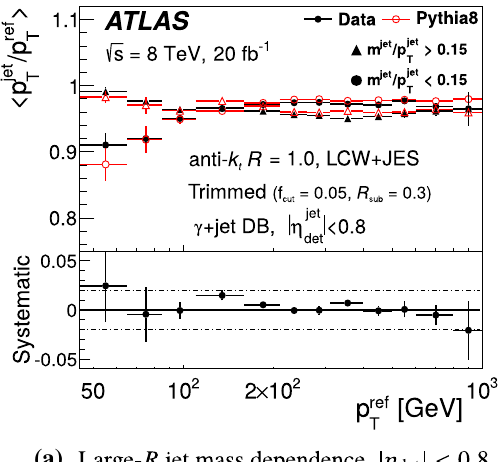
Fig. 30 R DB as a function of p ref markers and MC predictions as open makers. Statistical uncertainties measured for trimmed anti- k t T are shown for each point. The lower parts of the figures show the sys- jets with R = 1 . 0 in γ +jet events shown separately for jets with a | η det | < 0 . 8 and b 0 . 8 ≤ | η det | < 1 . 2. Separate results are shown tematic uncertainty evaluated as the data-to-MC ratio of the ratios of R DB extracted in the two m / p T ranges for jets with m / p T < 0 . 15 and m / p T > 0 . 15, displayed with circles and triangles, respectively. Measurements in data are shown as filled